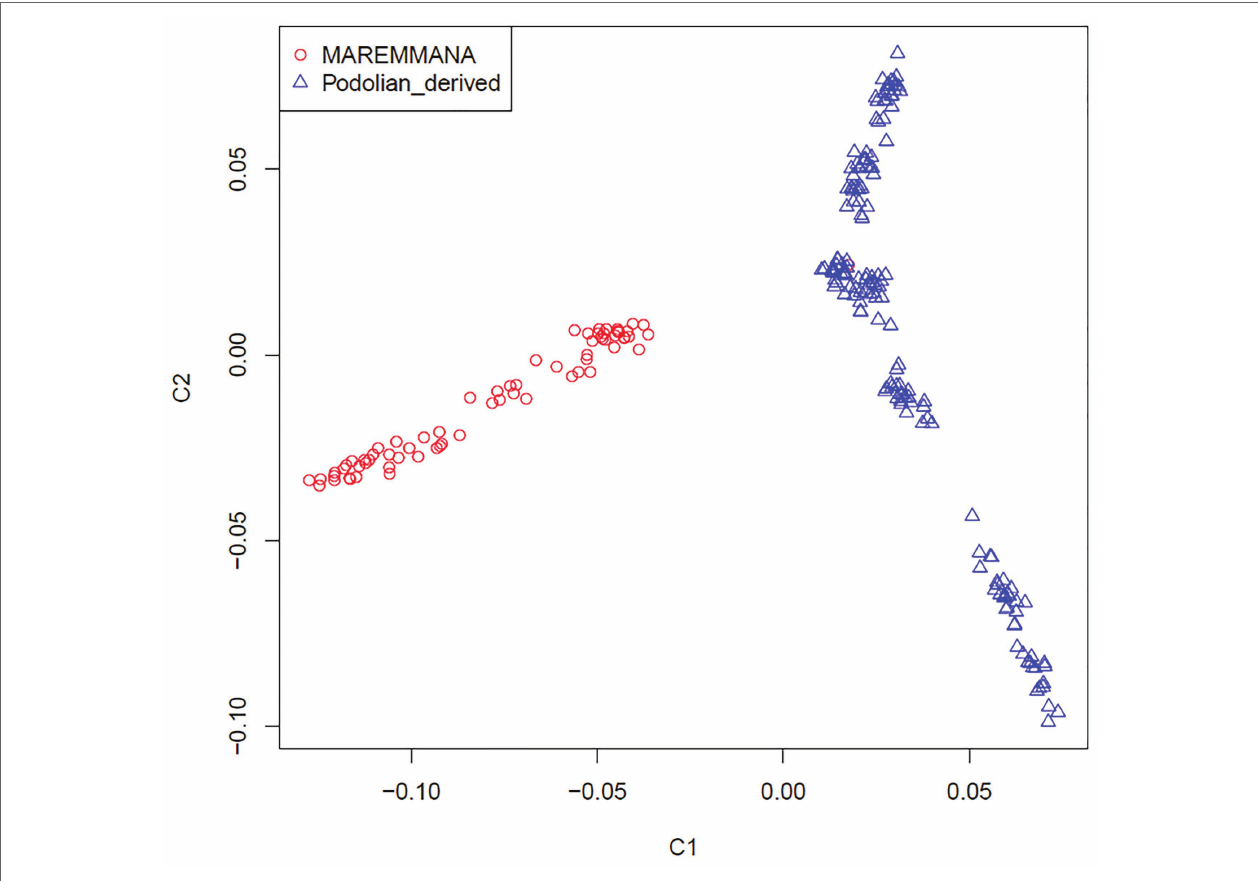
FIGURE 2 | Genetic relationship defined with multidimensional scaling (MDS) analysis between Maremmana and Podolian-derived